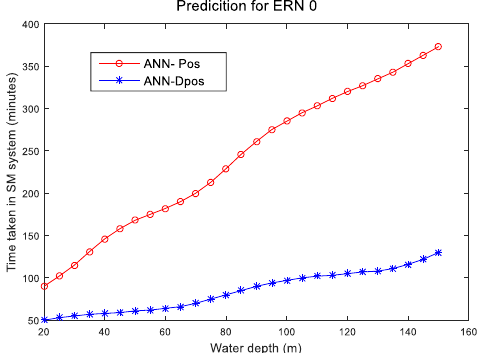
Figure 10. ANN-predicted SM set up and removal time at ERN 0.